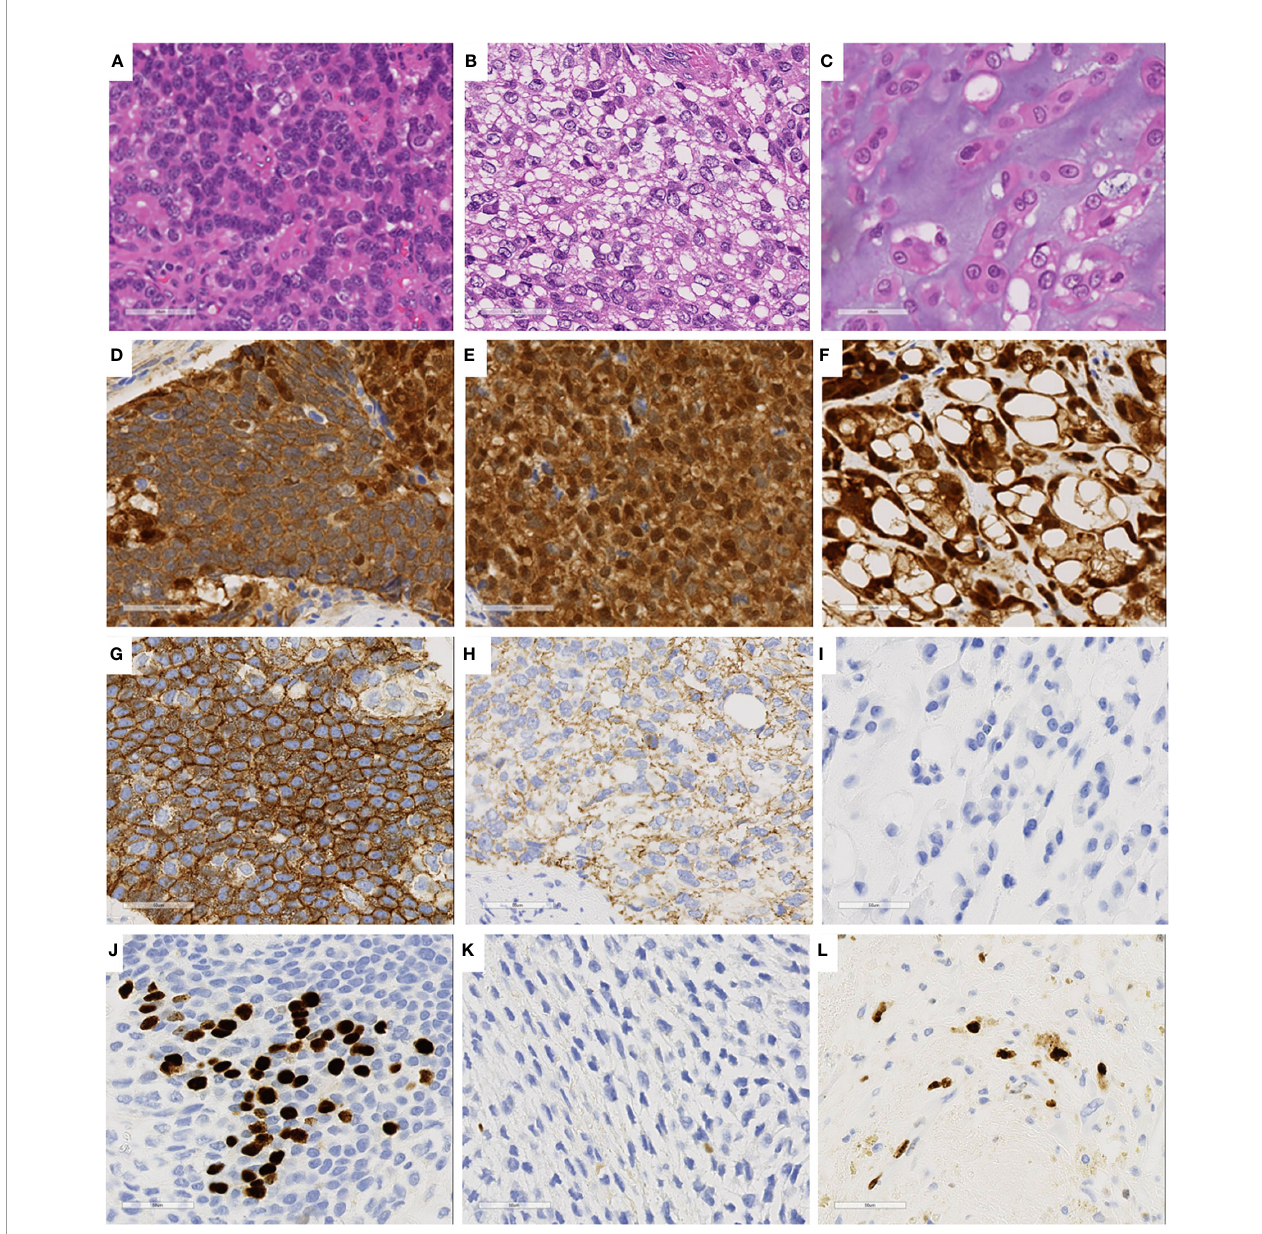
FIGURE 3 | Immunohistochemical staining of three characteristics cell components. (A, D, G, J) Basophilic cell lesion. (B, E, H, K) Clear cell lesion. (C, F, I, L) Cartilage-like component. (D – F) , b -catenin; (G – I) E-cadherin; (J – L)